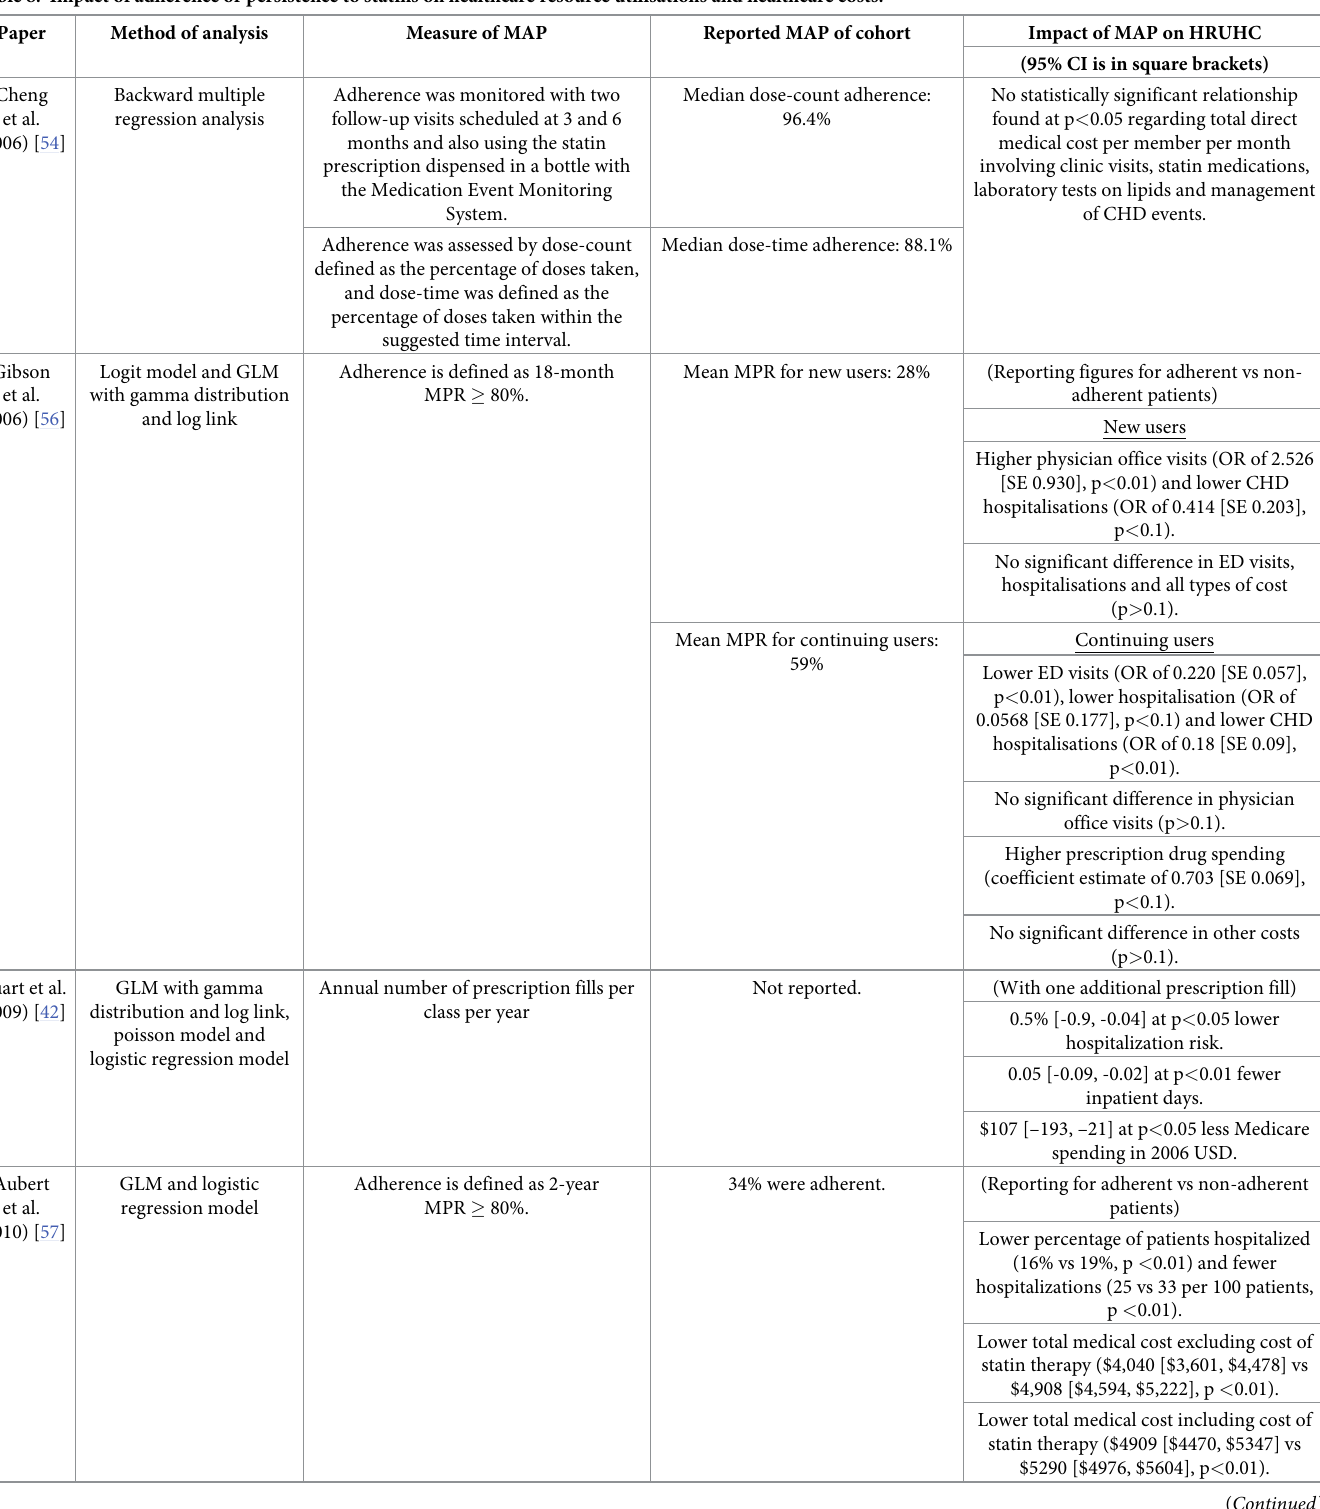
Table 8. Impact of adherence or persistence to statins on healthcare resource utilisations and healthcare costs.